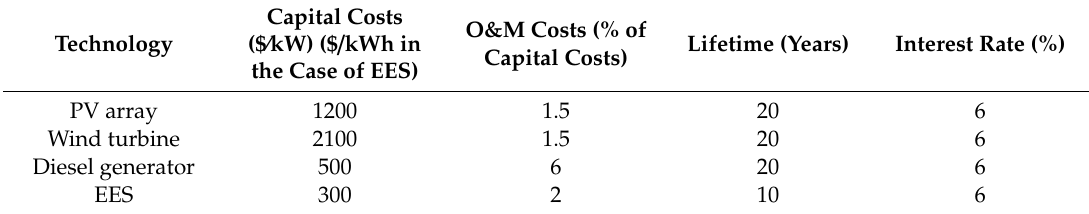
Table 1. Main technical and economic data of the considered system